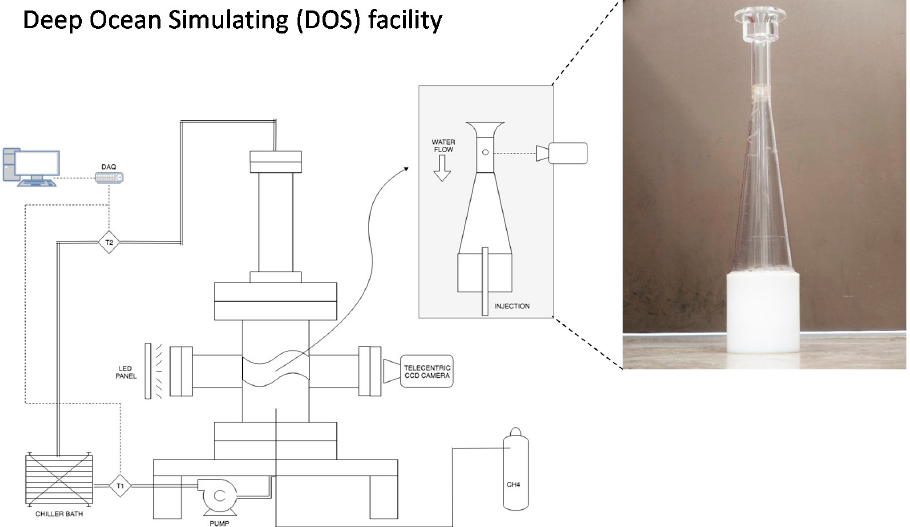
Figure 1. Schematic diagram of the Deep Ocean Simulator (DOS) facility.